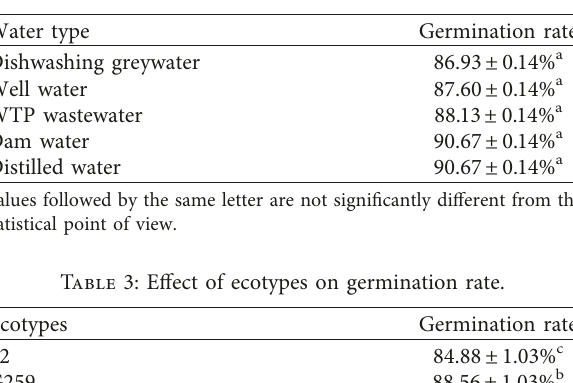
Table 2: Effect of watering water on the germinative performance of okra seeds.